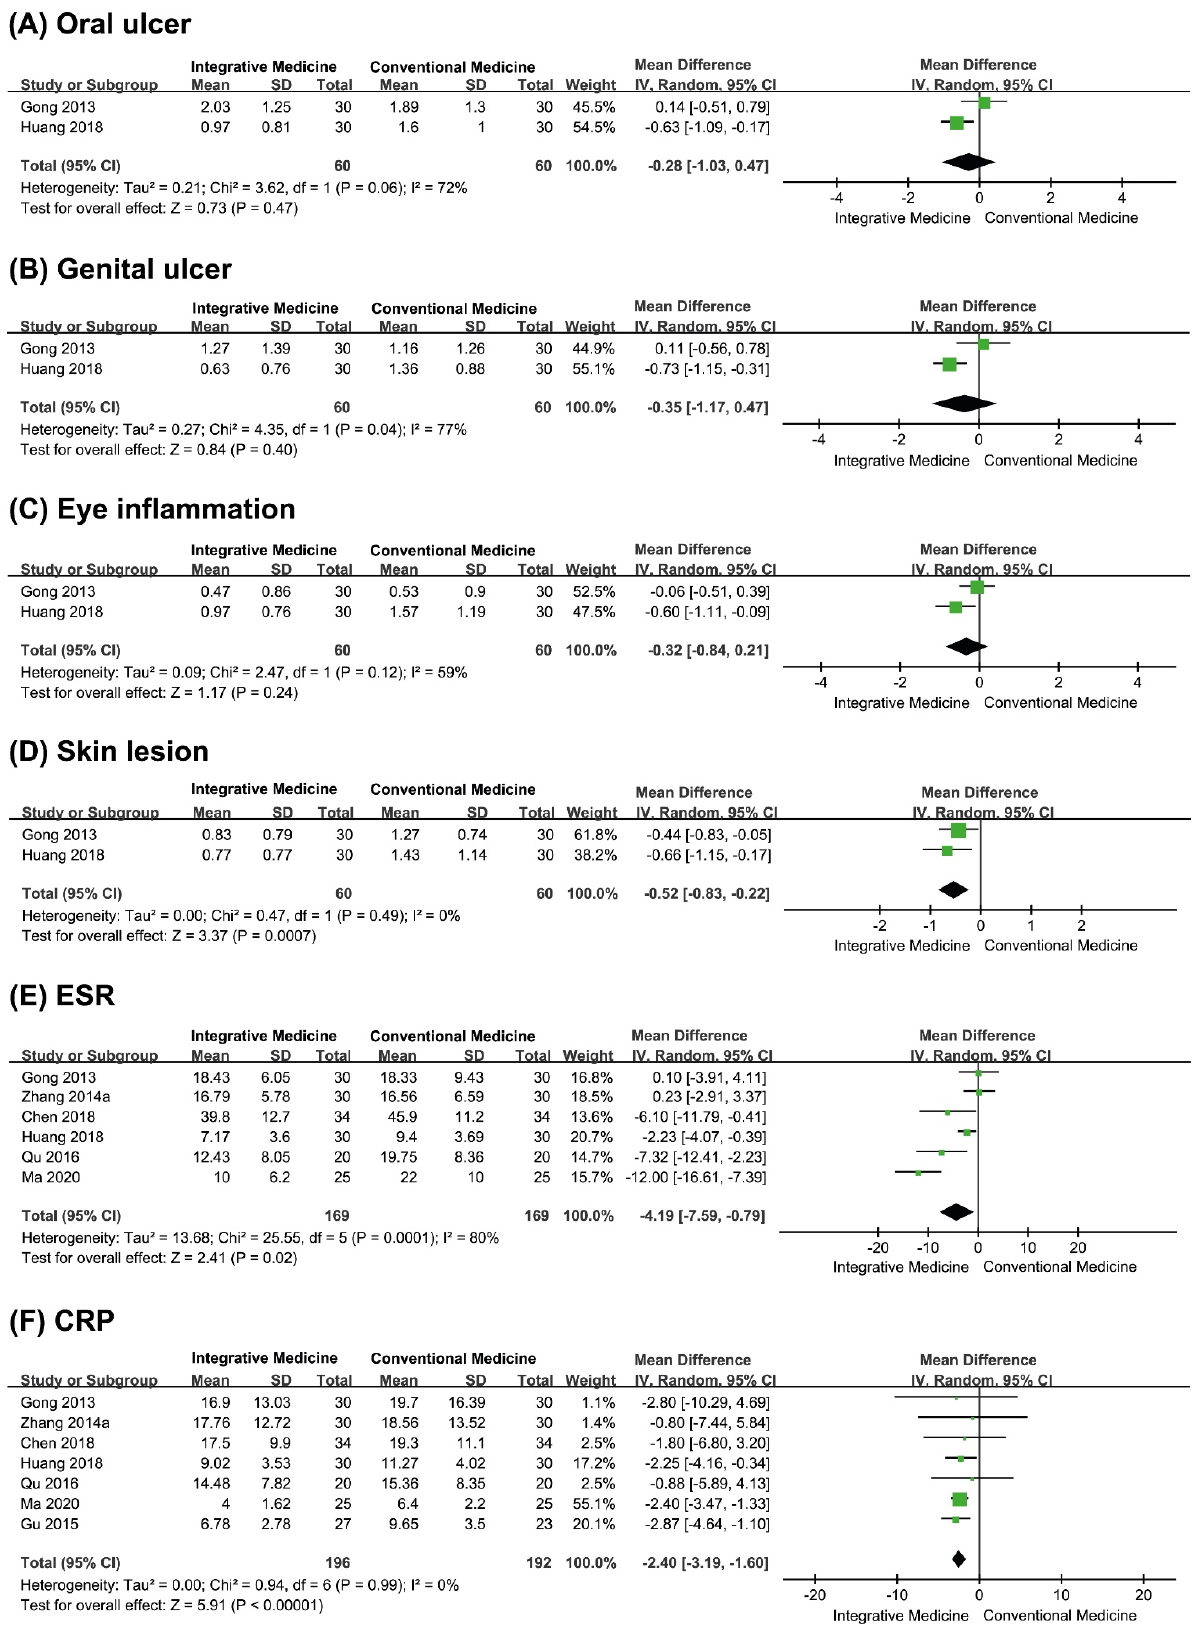
Figure 4. Forest plots of secondary outcomes. ( A ) Oral ulcers, ( B ) genital ulcers, ( C ) eye inflammation, ( D ) skin lesions, ( E ) ESR, ( F ) CRP.